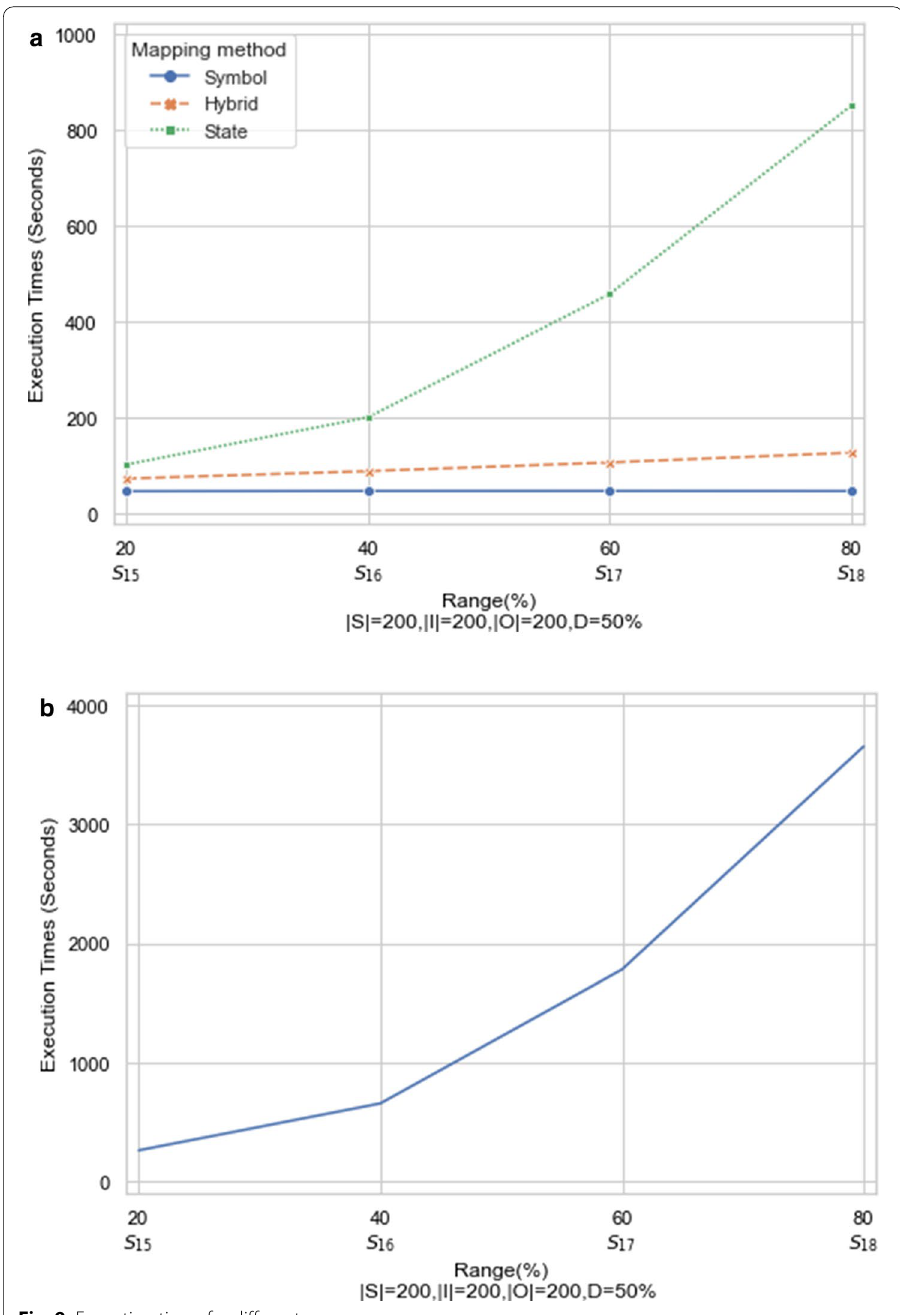
Fig. 9 Execution times for different